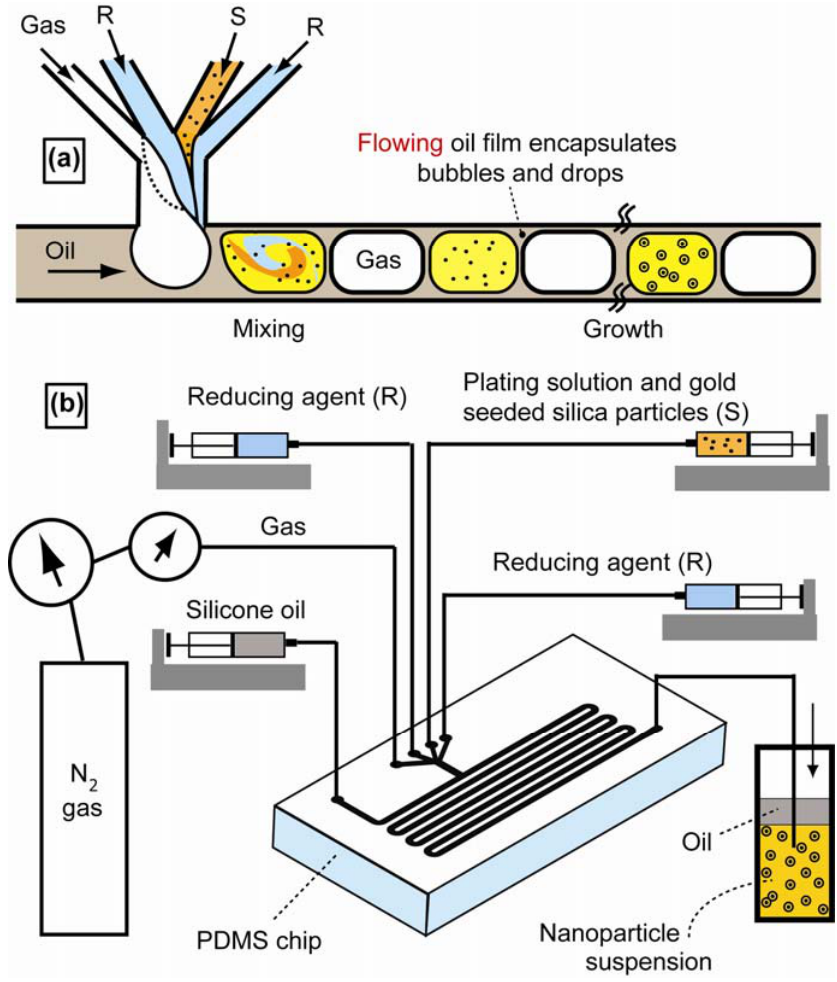
method. ( b ) Diagrammatic representation of the experimental setup. (Reprinted with permission from [17]. Copyright 2010 American Chemical